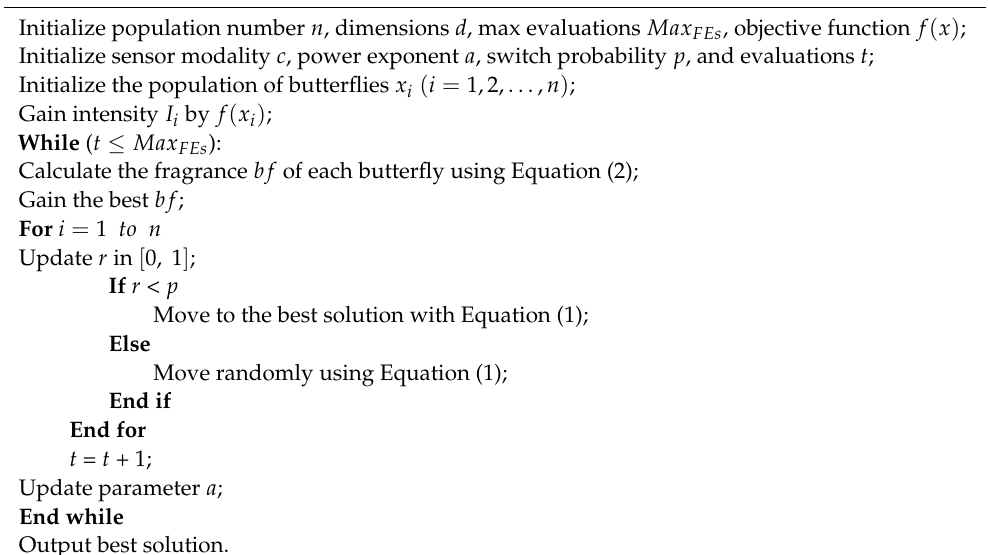
Algorithm 1: Pseudo-code of